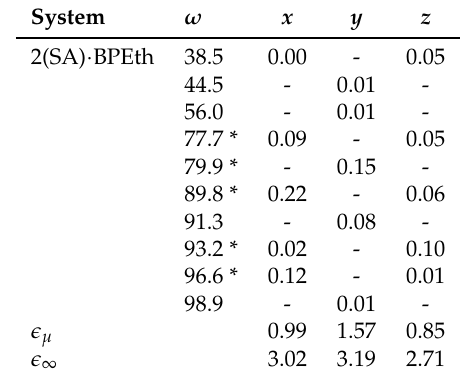
Table 8. Mode-by-mode analysis of the directional components of the IR active response of 2(SA) ·